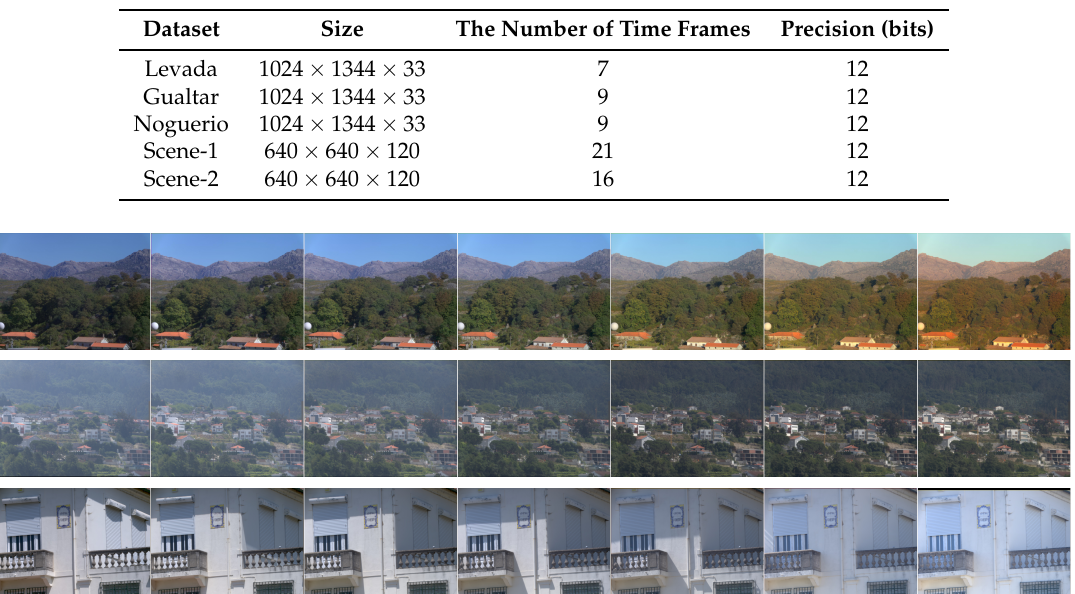
Table 1. Multitemporal hyperspectral image datasets.